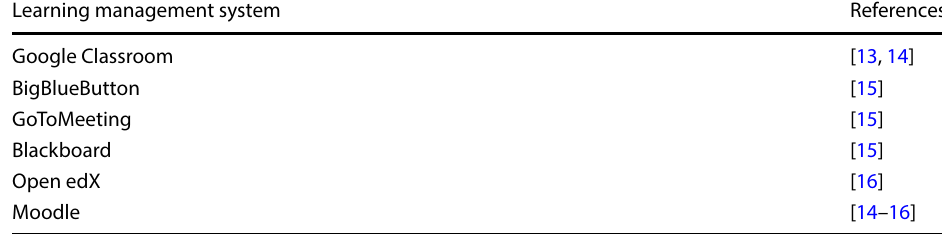
Table 1 Popular learning management